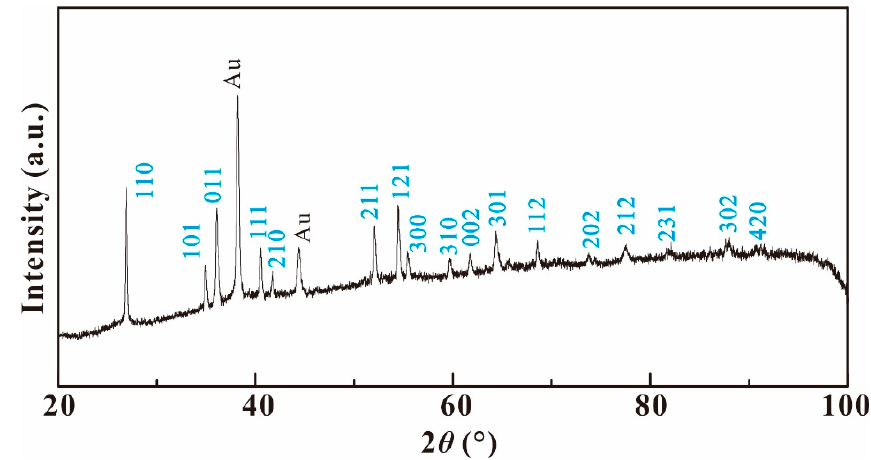
Figure 1. X-ray diffraction pattern of synthetic ε -FeOOH at ambient conditions. The sample was Figure 1. X-ray di ff raction pattern of synthetic ε -FeOOH at ambient conditions. The sample was checked under a Brucker D8 diffractometer with a wavelength of 1.5406 Å. The diffraction pattern checked under a Brucker D8 di ff ractometer with a wavelength of 1.5406 Å. The di ff raction pattern shows a pure phase of ε -FeOOH sample along with residual Au from the capsule. shows a pure phase of ε -FeOOH sample along with residual Au from the Table 1. Structural data for the synthesized ε -FeOOH under an ambient environment.